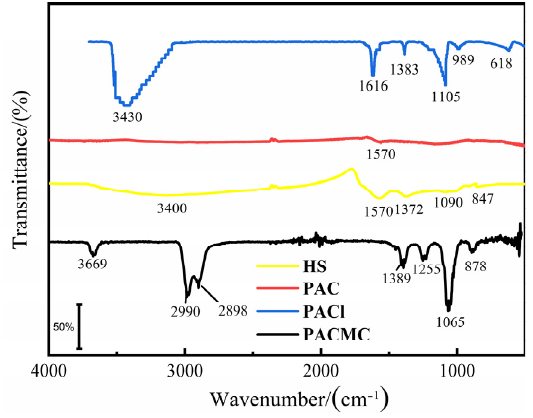
Figure 1. Infra-red spectra of PACMC and ingredient.